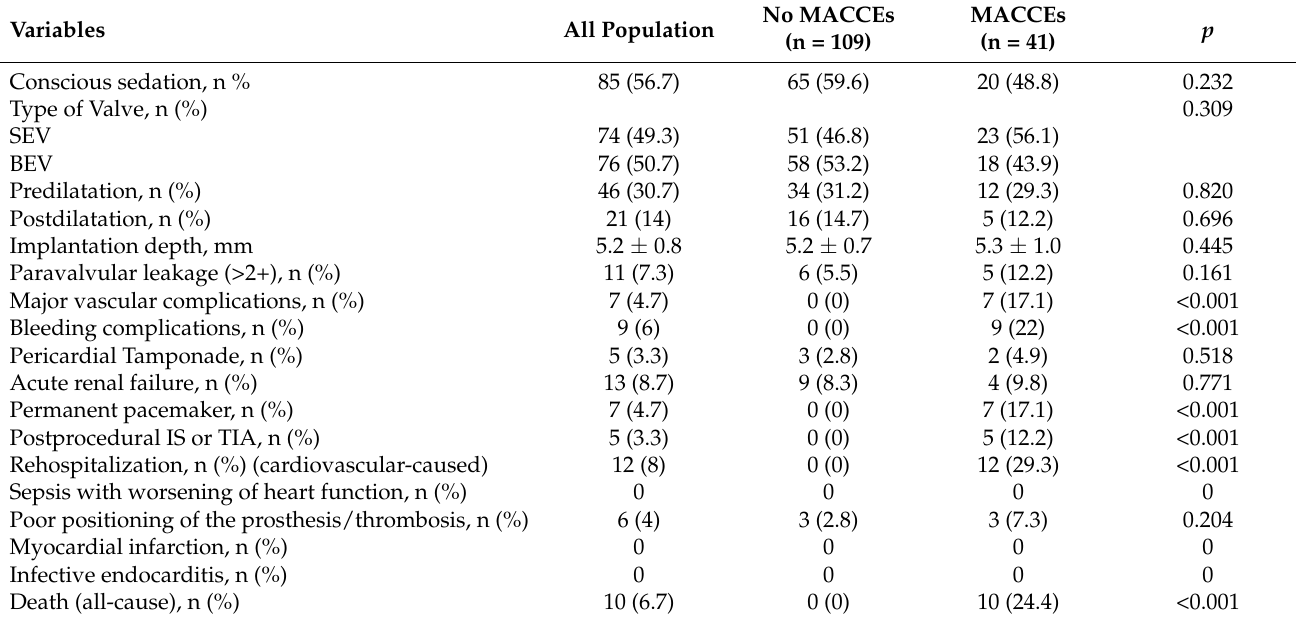
Table 2. Procedural and postprocedural parameters of study population during the follow-up